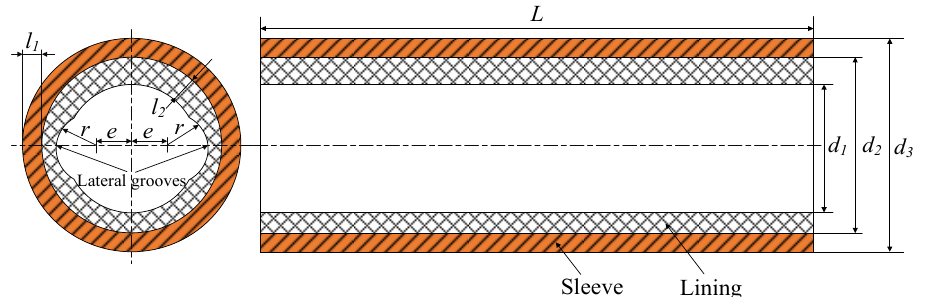
Figure 2. Structural diagram of the test bearing. Table 1. Main parameters of the test bearing.